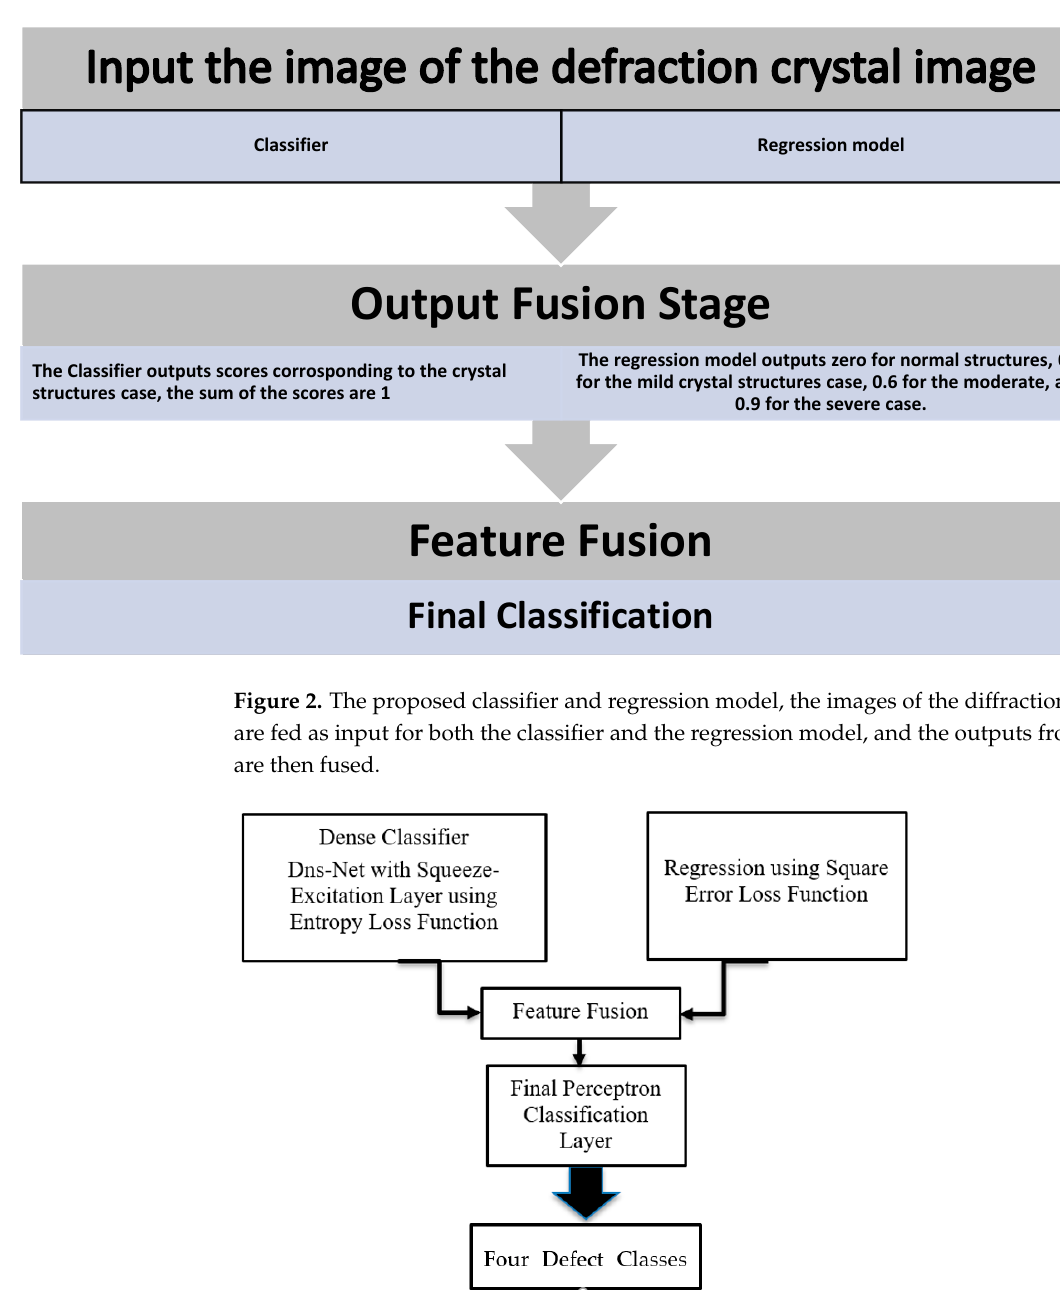
Figure 3. The Multitasking connected network with feature fusion from the squeeze model and the regression model where the classifier can predict the four classes for the input crystals.